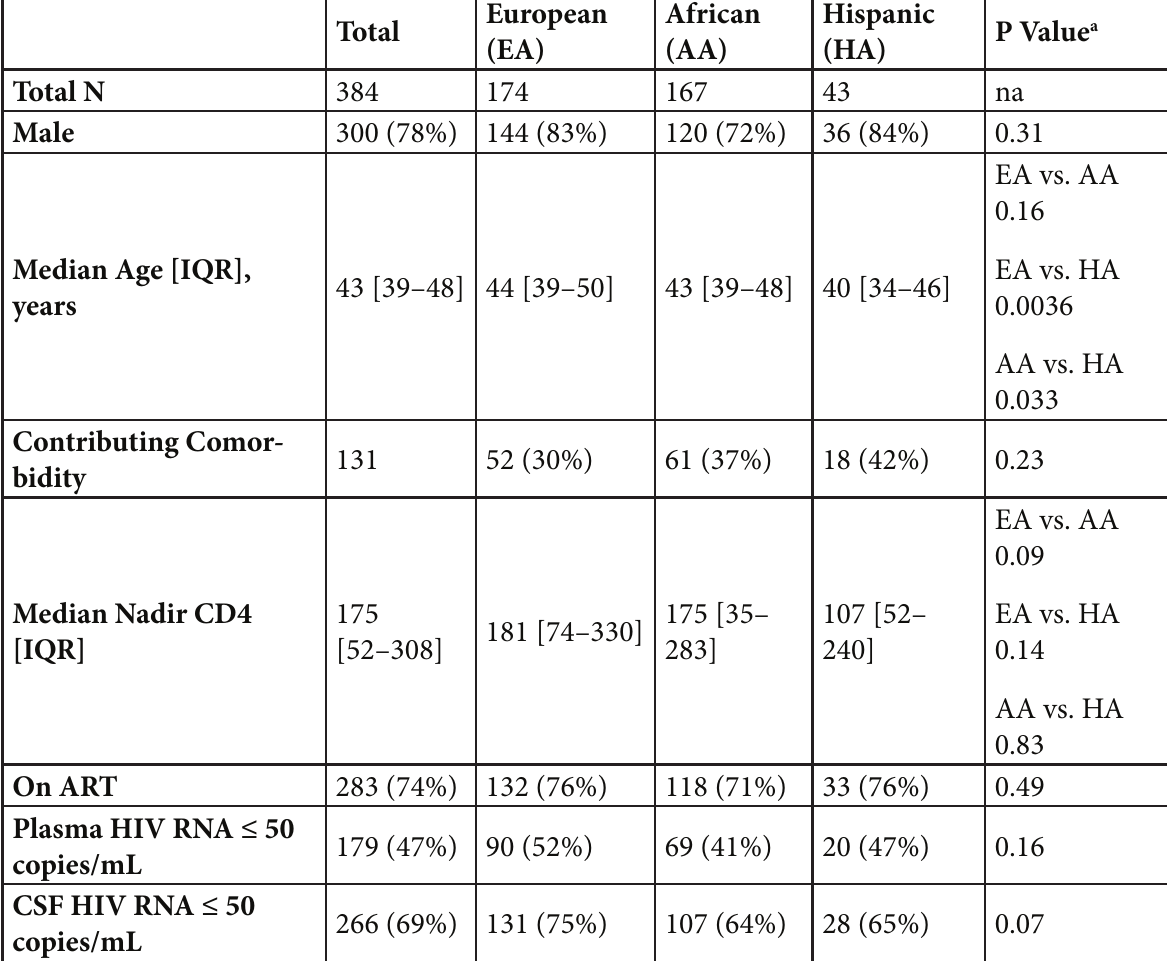
Table 1. Demographics of covariates for the 3 populations in the